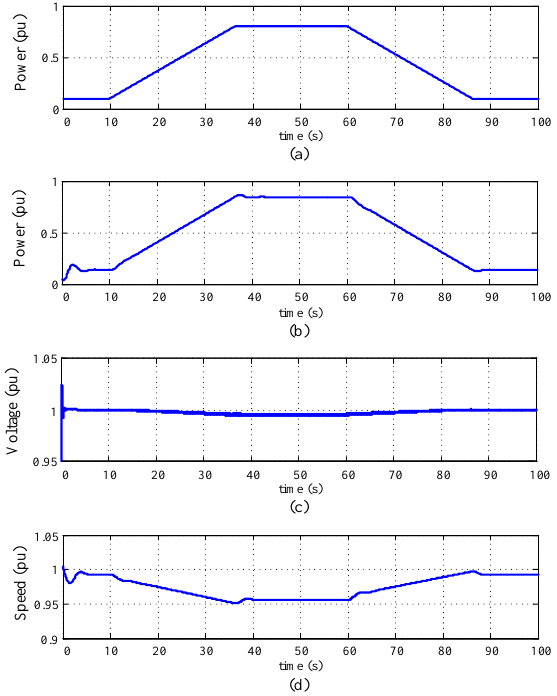
Figure 2. Simulation results of the power generation system: ( a ) Output power of the propulsion motor; ( b ) Output power of the steam turbine; ( c ) DC bus voltage; and ( d ) Frequency of the gener- ator.